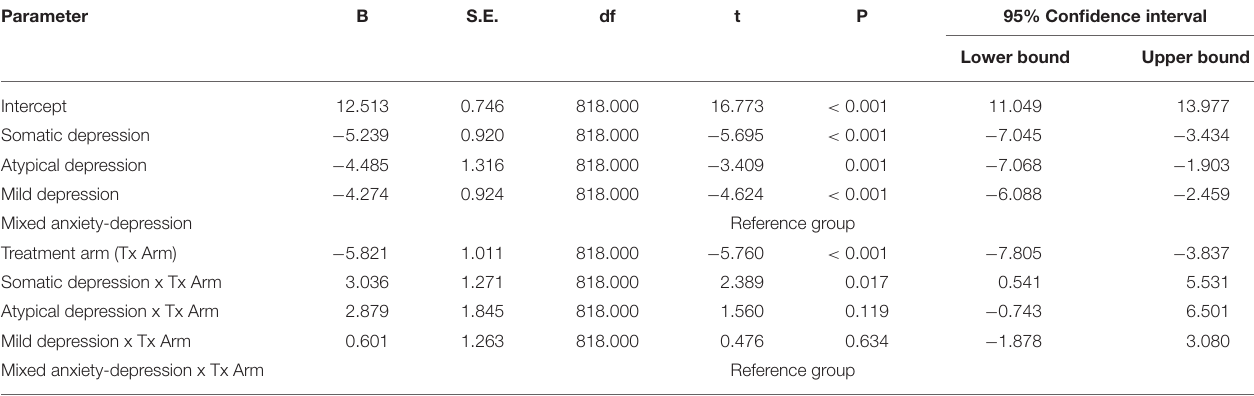
TABLE 3 | Linear fixed effects models for severity of depressive